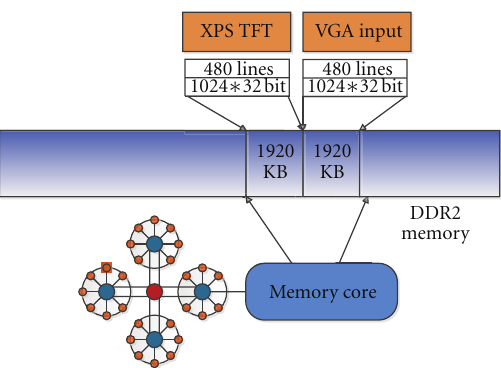
Figure 11: Memory core as Framebu ff er.